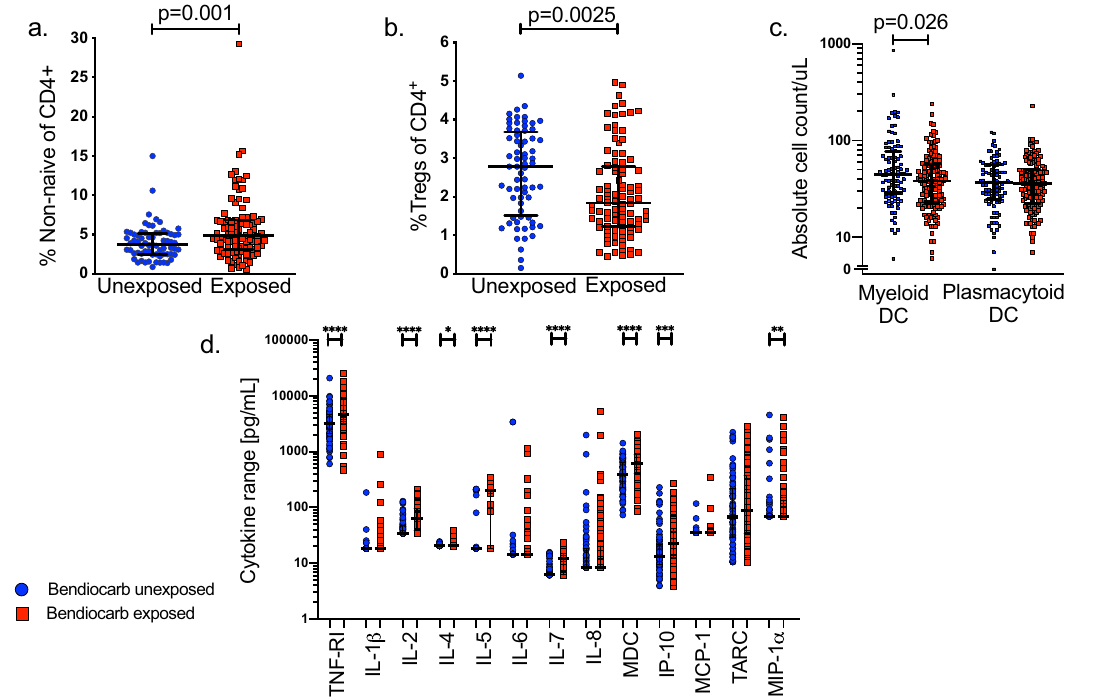
Fig. 2 Prenatal exposure to bendiocarb impacts CD4 T cell homeostasis, cytokine levels, and dendritic cell counts in cord blood. a Cord blood non-naive (Supplementary Fig. 1) CD4 T cell frequency in exposed (red, n = 98) and unexposed (blue, n = 68) infants. b Cord blood T reg frequency (CD25 high FoxP3 + CD127 lo ) in exposed (red, n = 98) and unexposed (blue, n = 68) infants. c Myeloid (Lin-2 – HLA-DR + CD11c + CD123 - ) and plasmacytoid (Lin-2 – HLA-DR + CD11c − CD123 + ) dendritic cell counts in whole cord blood, in exposed (red, n = 142) and unexposed (blue, n = 96) infants. d Cord blood plasma cytokine levels (unadjusted p values: TNF-RI ( p < 0.0001), IL-2 ( p < 0.0001), IL-4 ( p = 0.037), IL-5 ( p < 0.0001), IL-7 ( p < 0.0001), MDC ( p < 0.0001), TNF-RI ( p < 0.0001), IP-10 ( p = 0.0009), and MIP-1 α ( p = 0.01), ran in duplicate) in exposed (red, n = 114) and unexposed (blue, n = 73) infants. Following Bonferroni adjustment for all cytokines and chemokines measured, all associations indicated above remained signi fi cant with the exception of IL-4 and MIP-1 α . All comparisons were made by Wilcoxon rank-sum test. Bars indicate median with interquartile range. Two-sided p values were calculated for all test statistics.